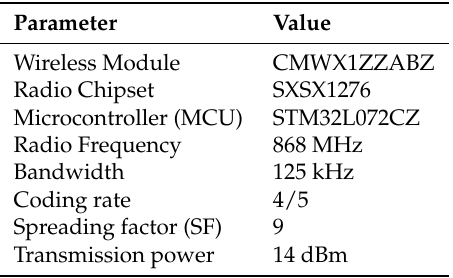
Table 3. LoRaWAN module